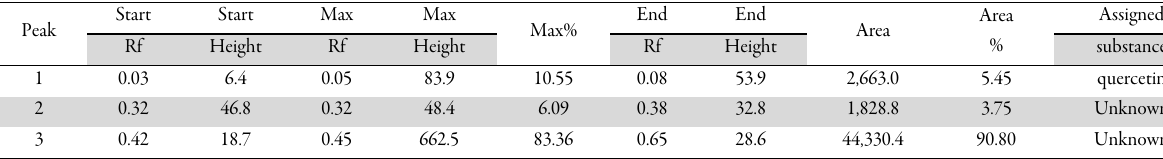
Table 3. HPTLC analysis of macerated ethyl acetate fruit extract